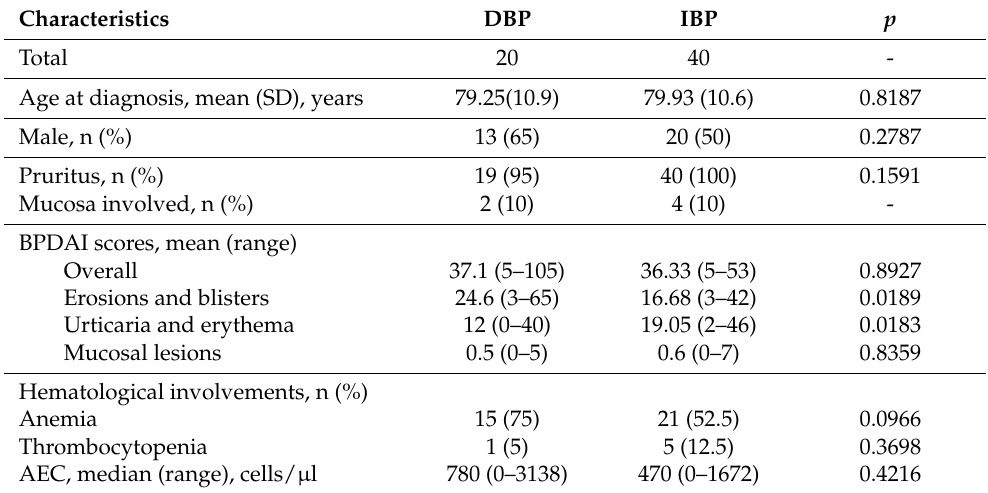
Table 1. Comparisons between DBP and IBP on demographic data, clinical features, and laboratory